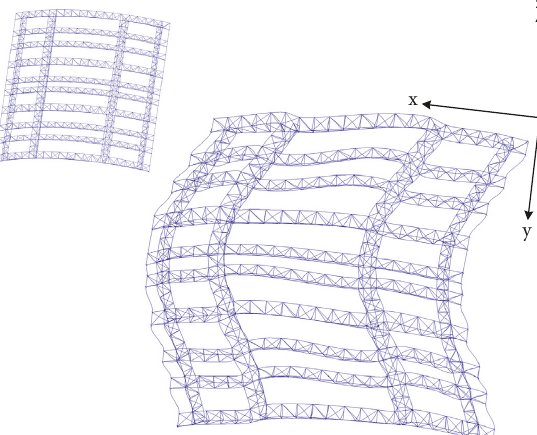
Figure 14: The 2nd mode shape (transverse).